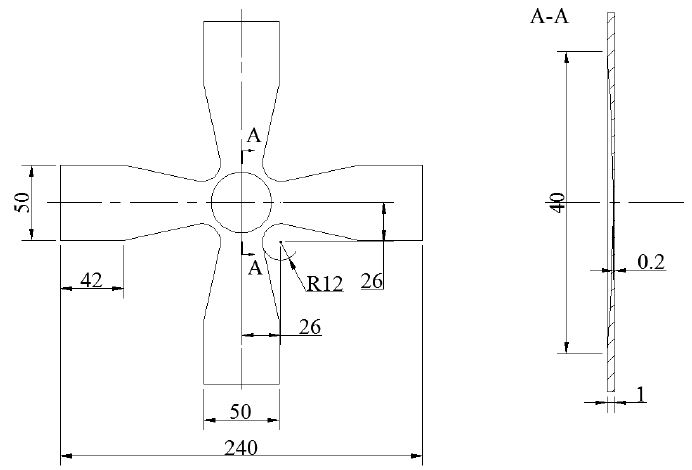
Figure 10. Specimen geometry of the biaxial tensile (unit: mm), where A-A is the cross section.